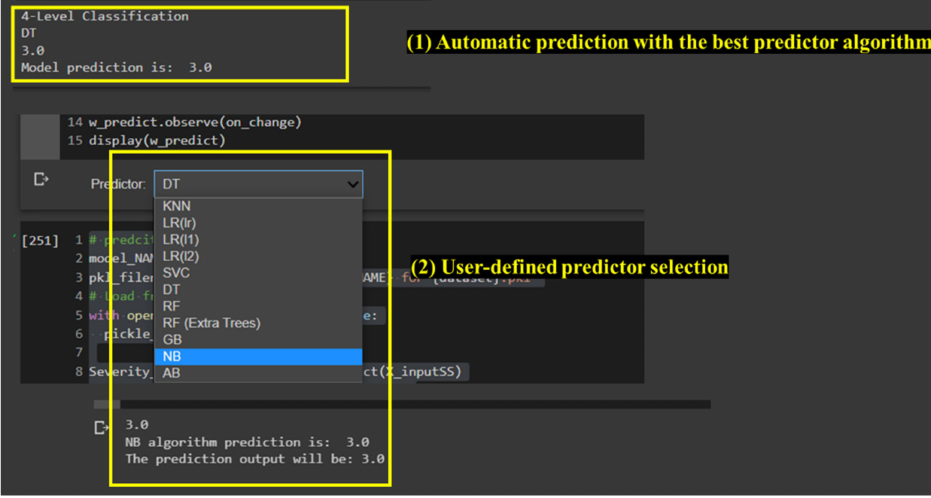
Figure 10. Severity prediction of newly entered accident dataset using a customized AutoML